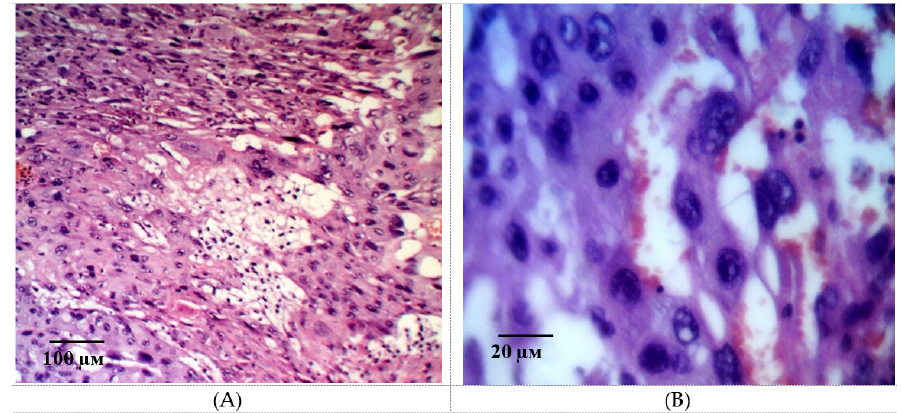
Figure 9. Microphotographs of the placenta on the 21st day of gestation in animals with ADMA-like preeclampsia when pHBSP was administered at the dose of 10 µg/kg. Note: Hematoxylin and eosin staining. Magnification: 200× ( A ) and 400× ( B ).